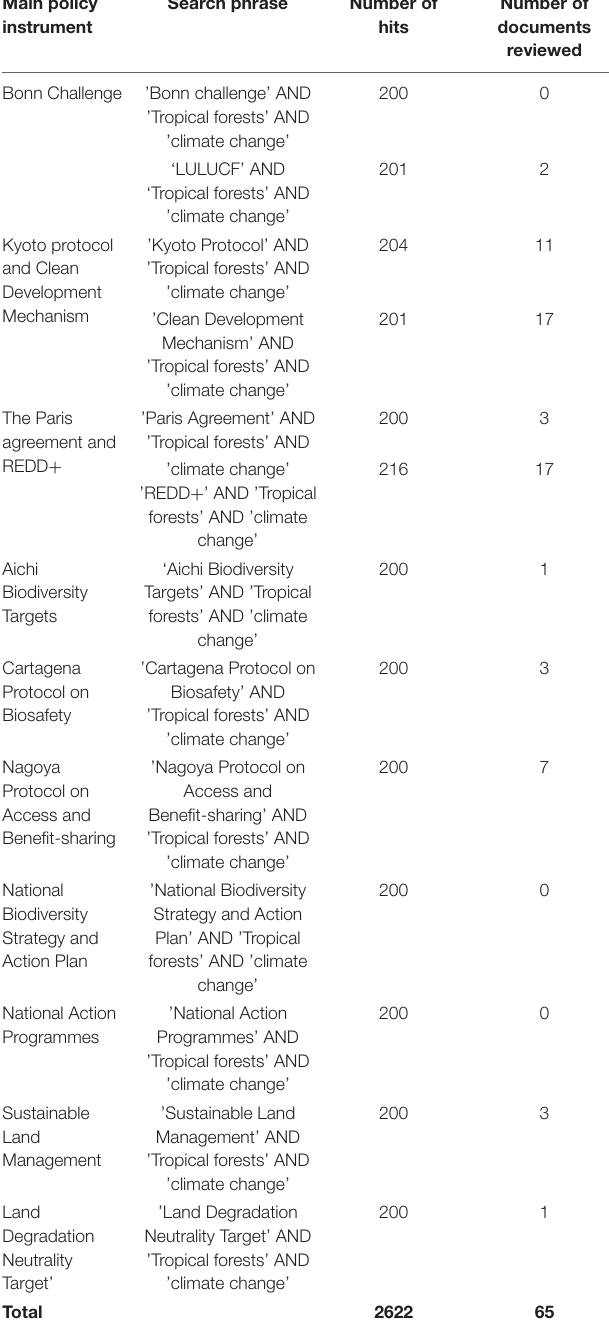
TABLE 2 | Summary of search phrase and areas of restriction between 1992 and